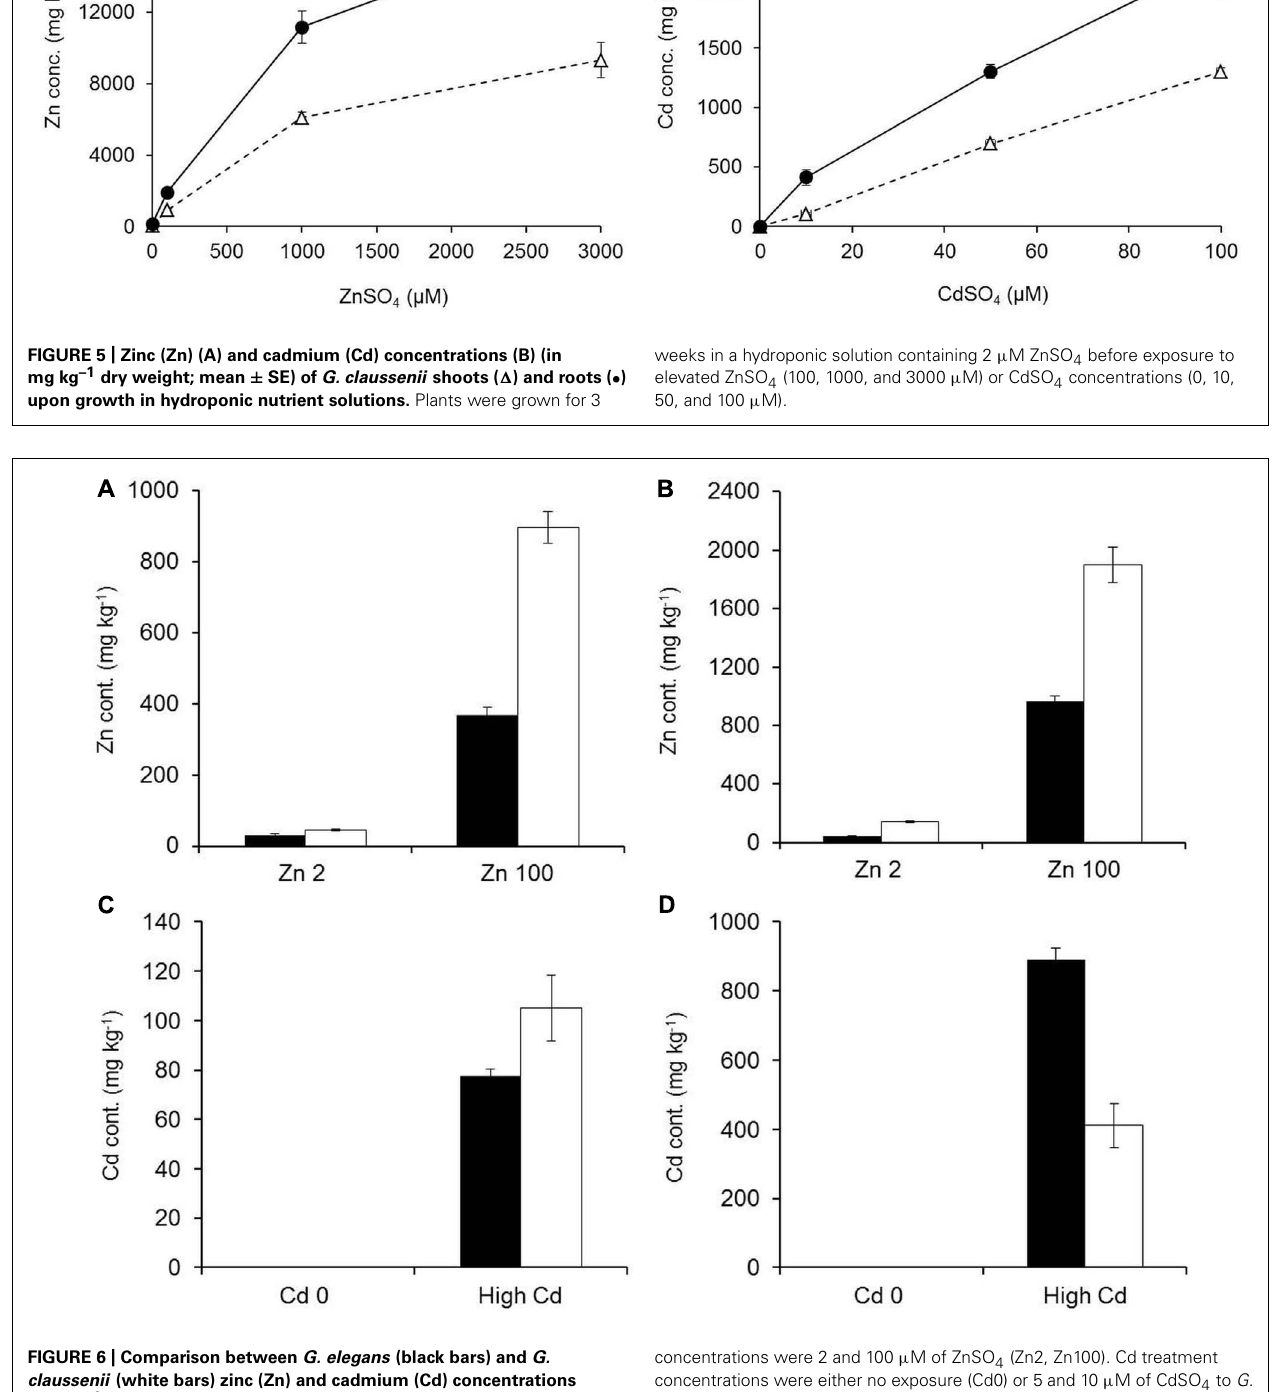
FIGURE 6 | Comparison between G. elegans (black bars) and G. claussenii (white bars) zinc (Zn) and cadmium (Cd) concentrations (mg kg –1 ; mean ± SE) in shoots (A,C) and roots (B,D) of plants exposed to comparable Zn (A,B) or Cd treatment levels (C,D). Zn treatment